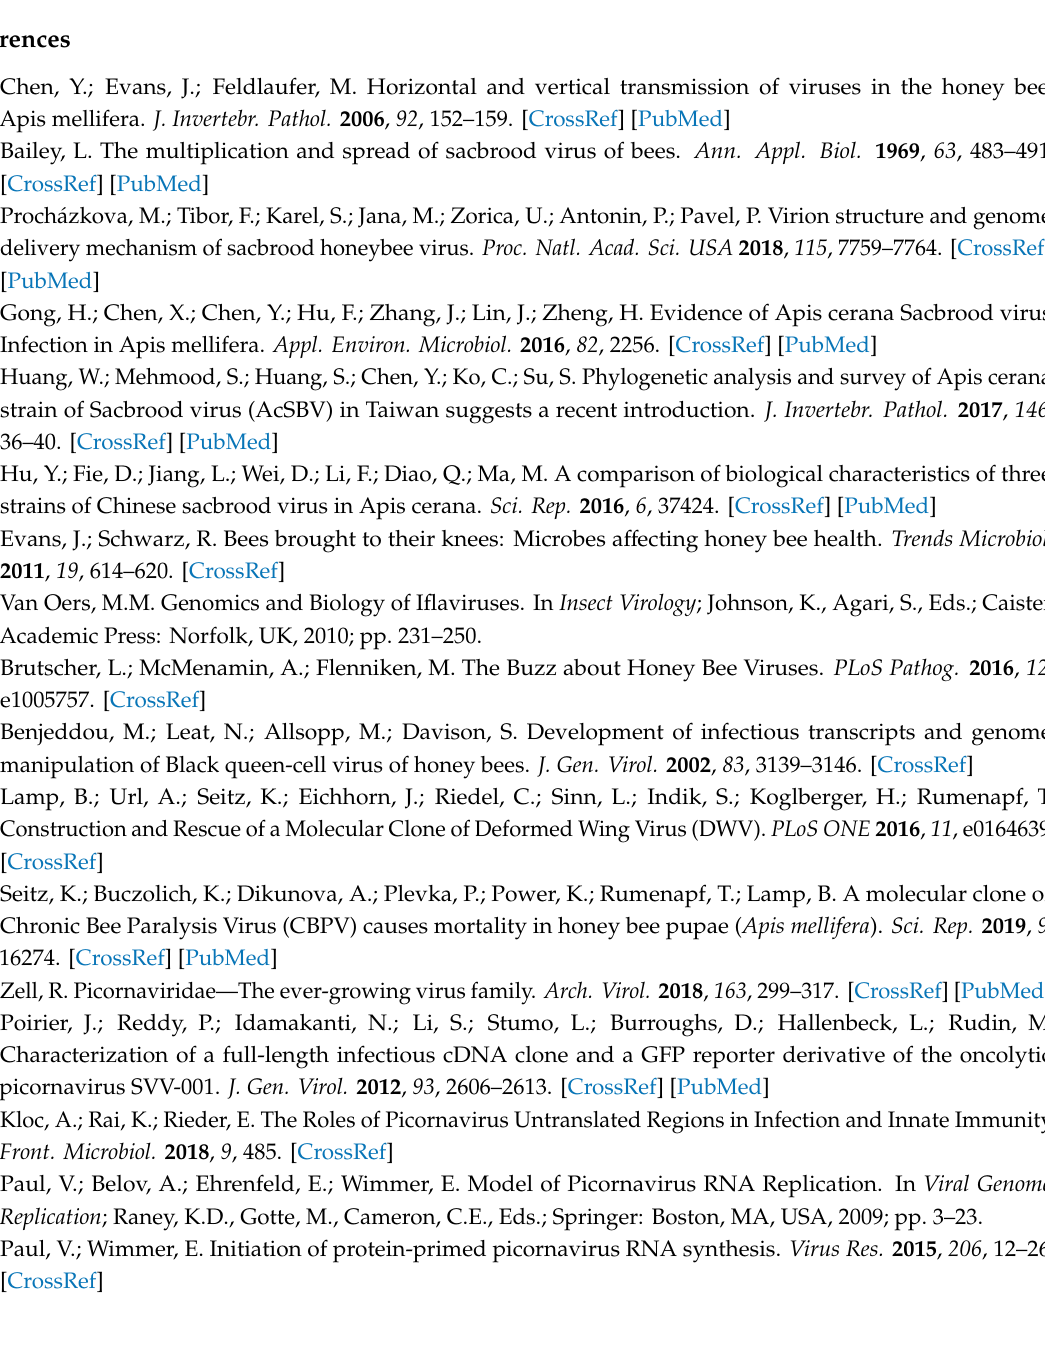
with Sacbrood-like symptoms. Figure S3: Negative stain of produced virions—transmission electron micrograph. Figure S4: Western blot analysis of randomly selected infected A. cerana larvae, the second oral passage (P2) of the clone. Table S1: Primers used in this